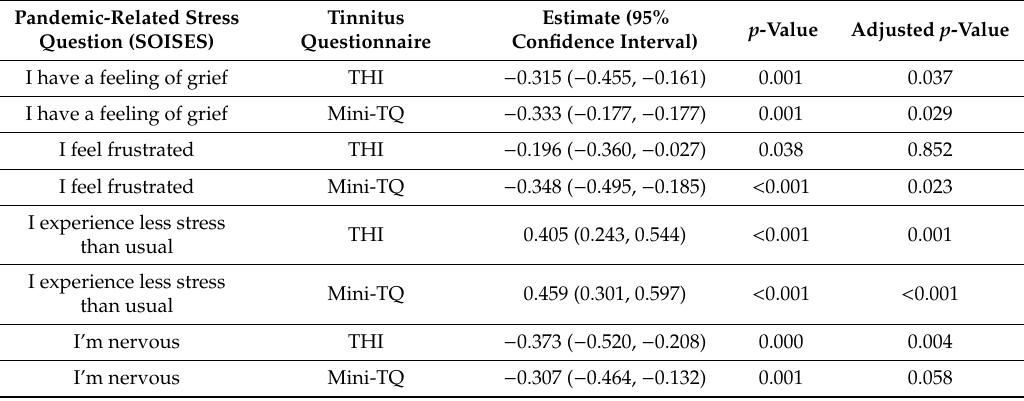
Table 3. Spearman correlations between tinnitus changes and pandemic-related burden. Tinnitus changes have been calculated by subtraction of the second time point (pandemic) from the first time point (baseline), meaning that positive change values indicate an increase of tinnitus-related